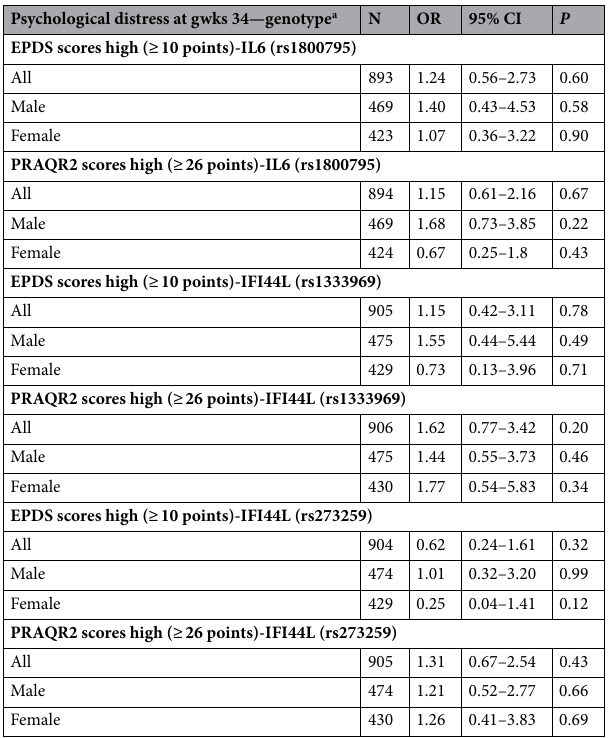
Table 3. The interaction of the exposure to prenatal maternal psychological distress and genotype for the risk of recurrent respiratory infections in all children and separately in males and females. CI confidence interval, EPDS the Edinburgh Postnatal Depression Scale, OR odds ratio, PRAQ-R2 the Pregnancy-Related Anxiety Questionnaire–Revised2. Studied as interaction logistic regression models and P values for the interaction terms. a Additive Model: major/major allele = 0, minor/major allele = 1 and minor/minor allele = 2.